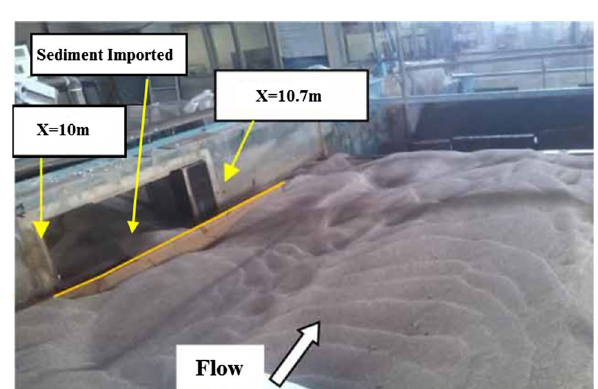
Fig. 9 Cross section in upper entrance ( X = 10 m) and lower entrances ( X = 10.7 m) in main